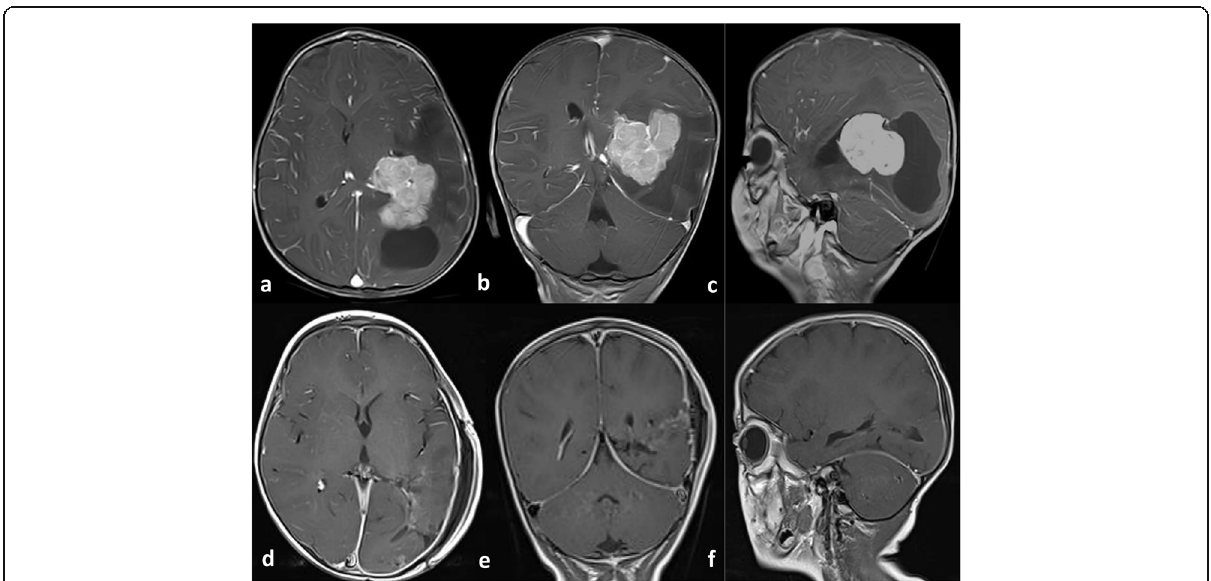
Fig. 5 A large left sided intraventricular choroid plexus carcinoma in a 3-year-old female patient. a – c The preoperative axial, coronal, and sagittal contrast-enhanced brain MRI study. d – f The postoperative axial, coronal, and sagittal contrast-enhanced brain MRI study. Total excision of the tumor was achieved following a left posterior parietal trans-cortical